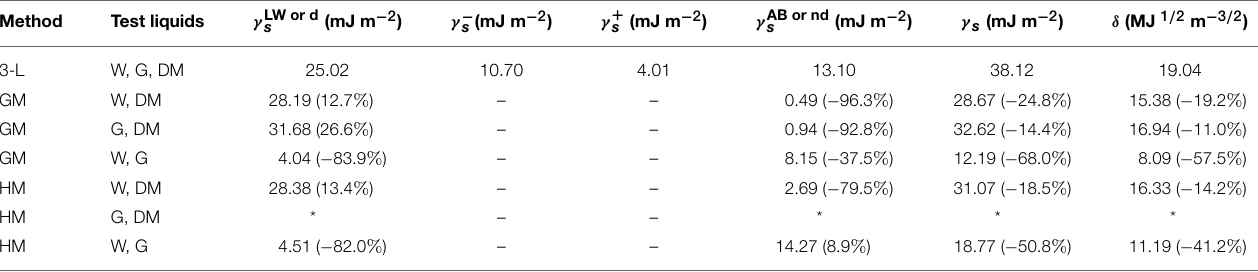
TABLE 7 | Surface free energy ( γ s ) and its components ( γ LW or d s